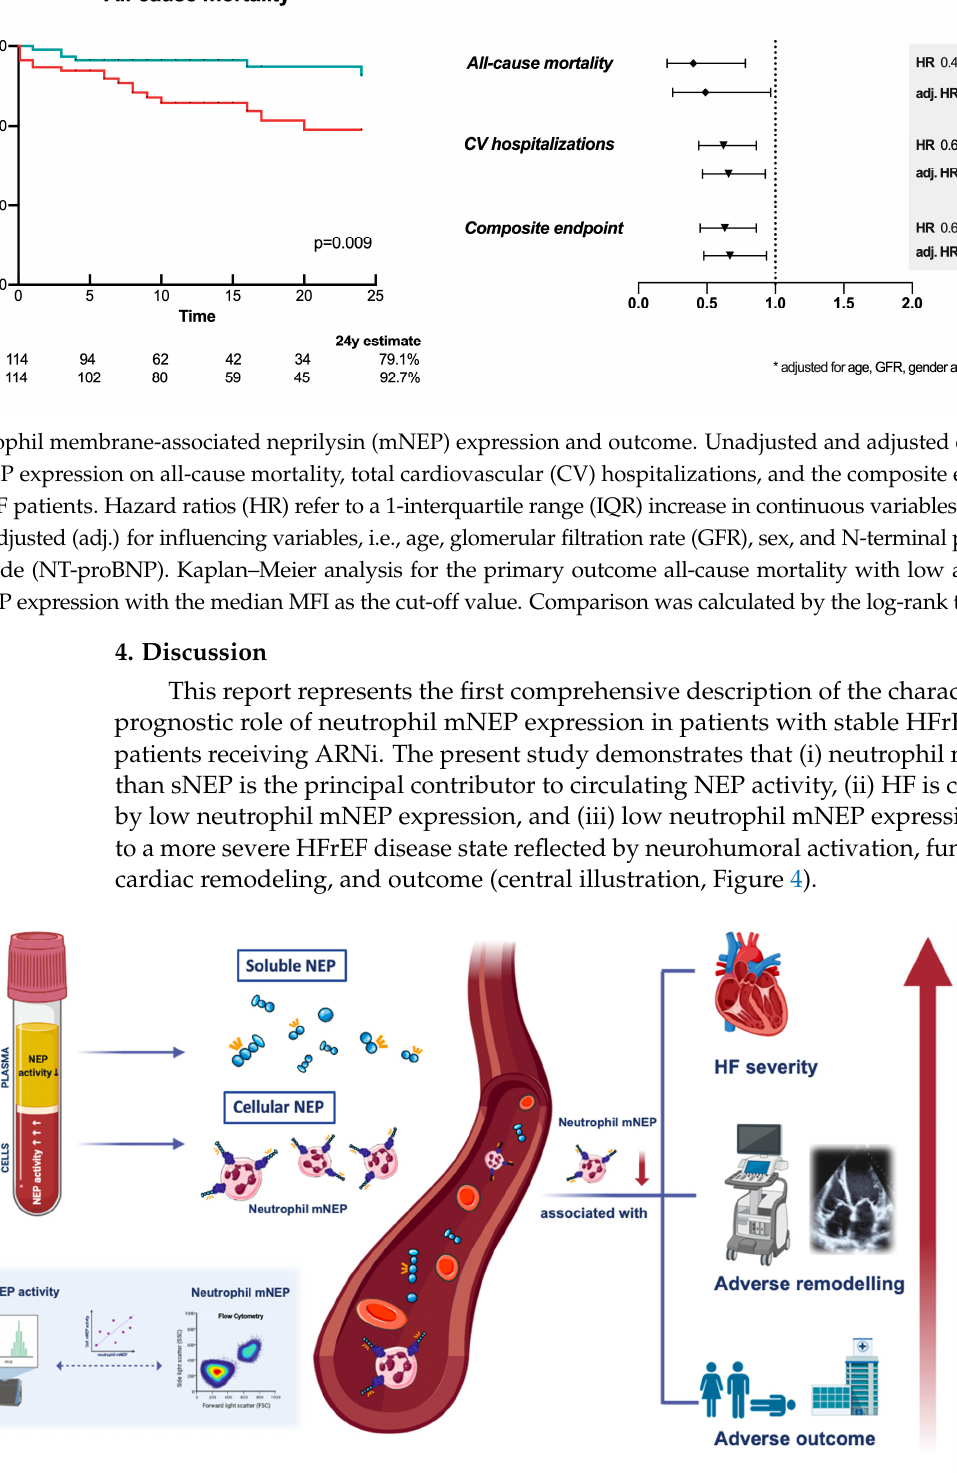
Figure 4. Central illustration. Neprilysin (NEP) can be released in the circulation by ectodomain shedding resulting in a soluble form of NEP. Besides the non-membrane associated form of NEP, NEP can be detected on neutrophils (cellular transmembrane NEP [mNEP]) by flow cytometry. Low neutrophil mNEP is significantly associated with progressing heart failure severity, reflected by New York Heart Association classification and N-terminal pro-brain natriuretic peptide, adverse remodeling, and poor prognosis. NEP activity of the circulating cellular compartment determined by liquid chromatography-tandem mass spectrometry (LC-MS) is markedly increased compared with plasma and correlates with neutrophil mNEP